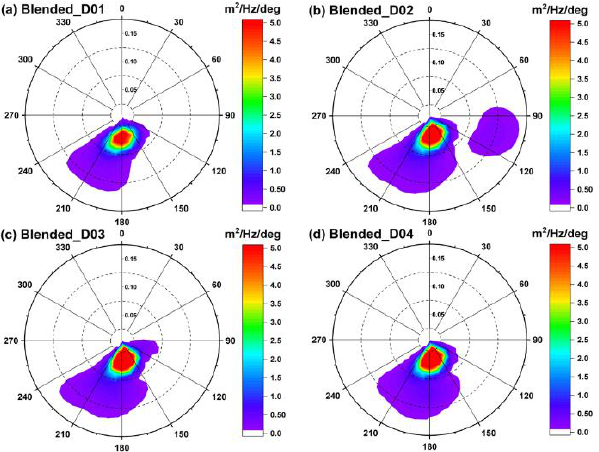
Figure 26. Comparison of the directional wave spectra at the Taitung wave buoy at 00:00 on 27 September 2016, using the four computational domains ( a – d ) and blended wind fields.